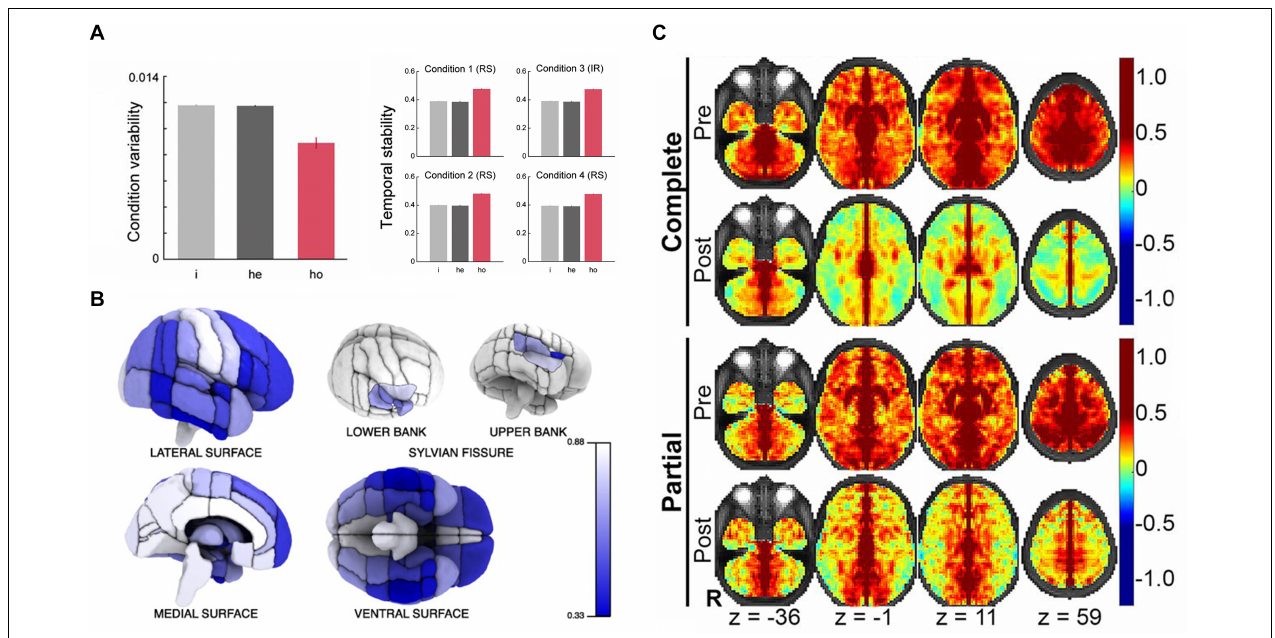
FIGURE 2 | The basic characteristics and structural foundation of HoFC. (A) The condition variability and temporal stability for different types of functional connectivity, including intrahemispheric (i), heterotopic (he), and homotopic (ho). The figure is adapted from Shen et al. (2015). Permission to reuse Figures 2 , 3 from the article was granted by PNAS. (B) Mean interhemispheric HoFC indicated for all cortical regions. The figure is adapted from Stark et al. (2008). Permission to reuse Figure 4 from the article was granted by Society for Neuroscience (“Copyright [2008] Society for Neuroscience”). (C) HoFC computed as the Fisher Z-transformed VMHC before (first and third rows) and after (second and forth rows) corpus callosotomy (complete and partial). The figure is adapted from Roland et al. (2017). Permission to reuse Figure 4 from the article was granted by